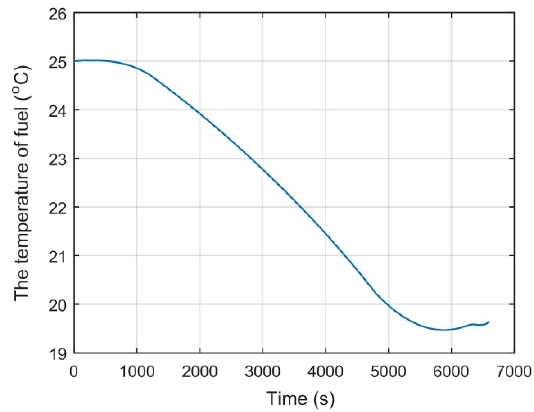
Figure 12. Variation of fuel temperature inside wing fuel tank.